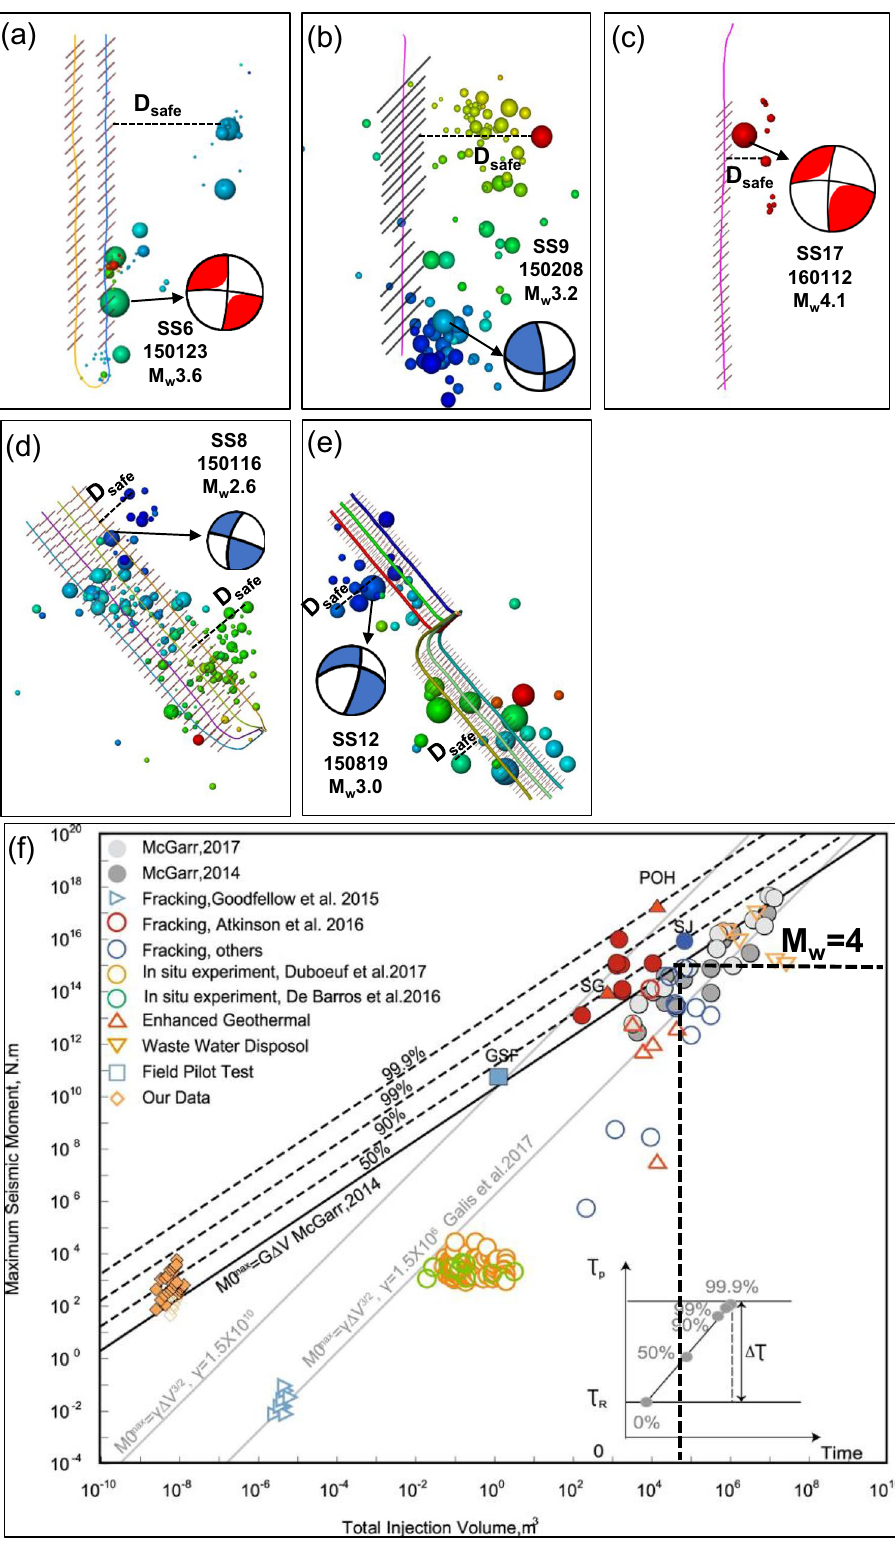
Figure 4. ( a–e ) Maps of fracturing horizontal wells and monitored induced seismicity events for five cases. The fracturing horizontal wells are divided into the N–S-oriented wells (SS6, SS9, and SS17) and NW–SE-oriented wells (SS8 and SS12) 19 . D safe denotes the safe distance between fracturing wells and potential faults. ( f ) Maximum seismic moment vs. total injection volume for fluid-injection-induced earthquakes by Li et al. 34 . The magenta line denotes the possible maximum fluid injection of 89,000 m 3 with a potential seismicity magnitude of less than